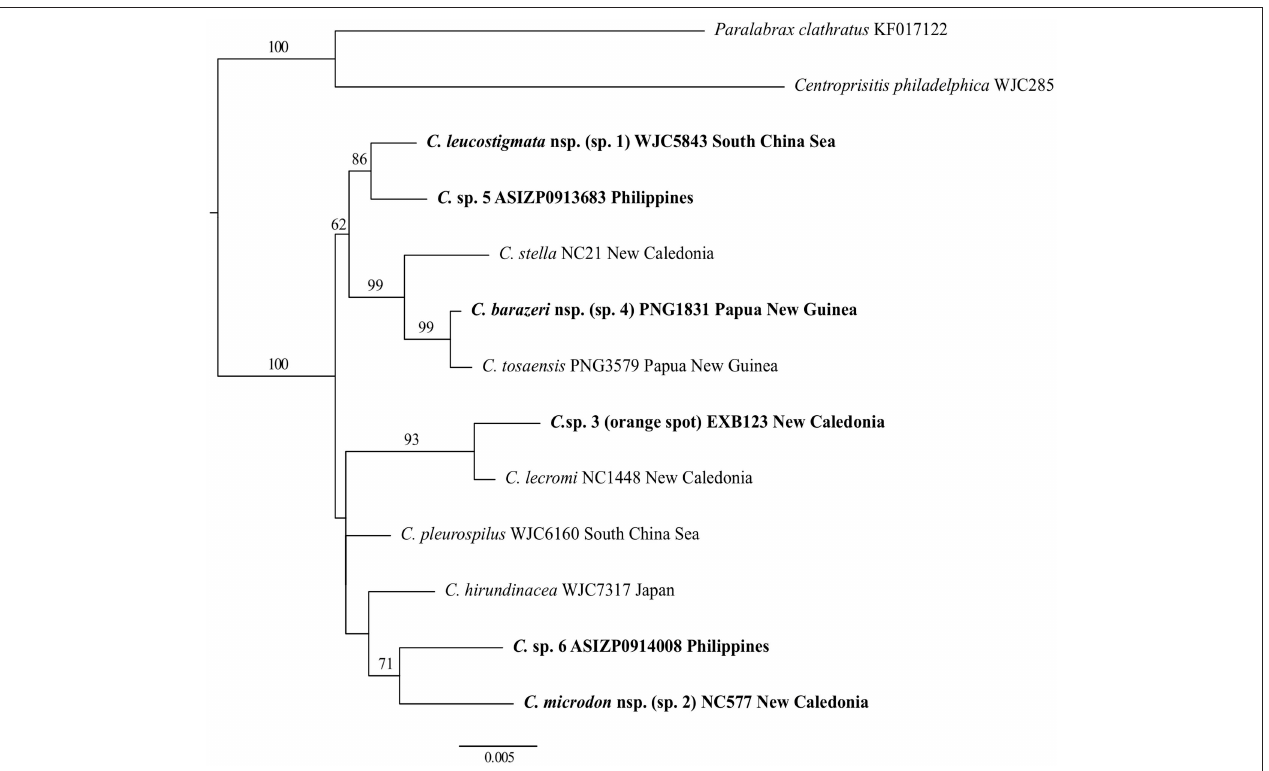
FIGURE 3 | Phylogenetic tree of Chelidoperca species inferred by the partitioned maximum-likelihood method with GTR + G nucleotide substitution model based on the RAG1 gene dataset. Branch lengths are proportional to inferred nucleotide substitutions. Numbers at nodes represent bootstrap values in percentages. Values < 50% are not shown. Taxa names in bold indicate new or potential new species discovered in this study. The tree is rooted with two known species from the